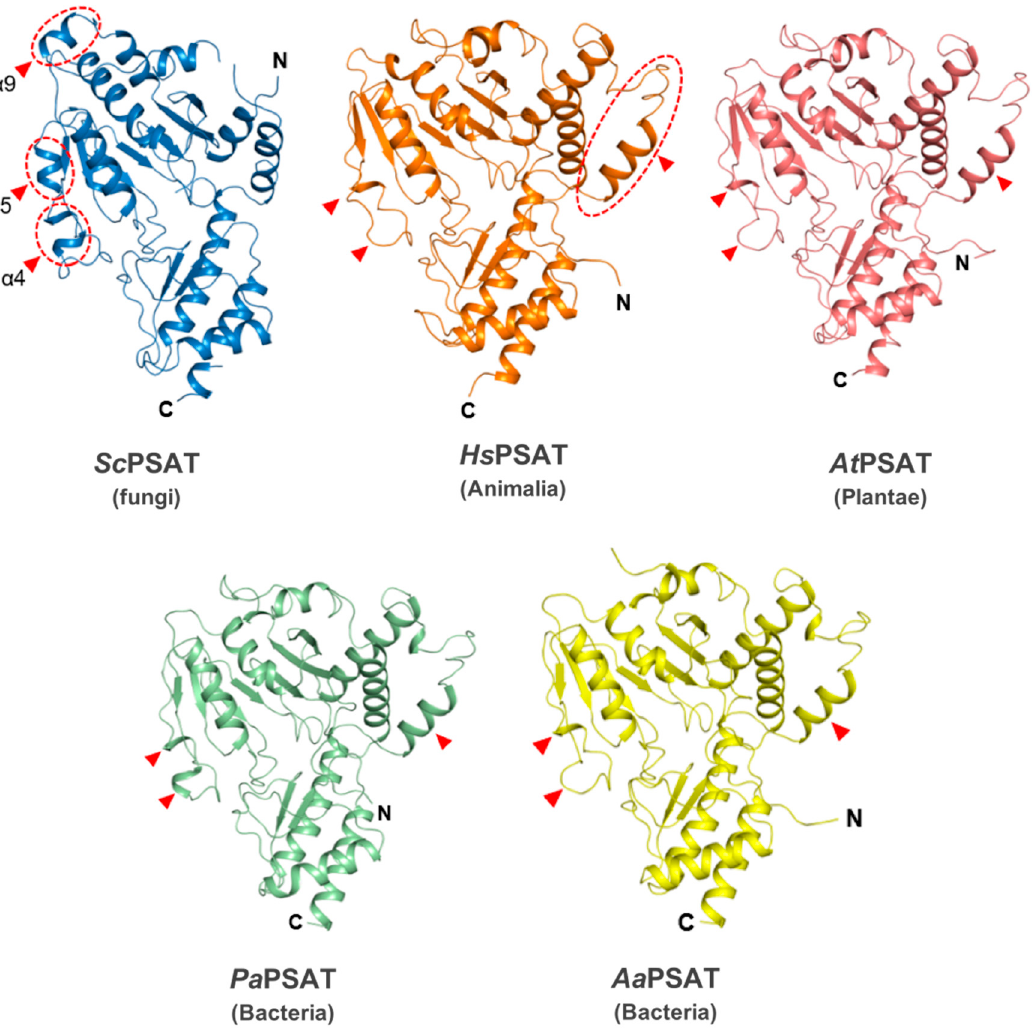
Figure 2. Structural comparisons of Sc PSAT with its homologs. Overall structures of Sc PSAT (blue), H. sapiens PSAT ( Hs PSAT; PDB code: 3E77; orange), A. thaliana PSAT ( At PSAT; PDB code: 6CZX; pink), P. aeruginosa PSAT ( Pa PSAT; PDB code: 4XK1; green), and A. alcalophilus PSAT ( Aa PSAT; PDB code: 1W23; yellow). Secondary structural elements α 4, α 5, and α 9 helices of Sc PSAT are marked accordingly. Red-dashed ovals and red arrowheads indicate the positions of distinct conformations.